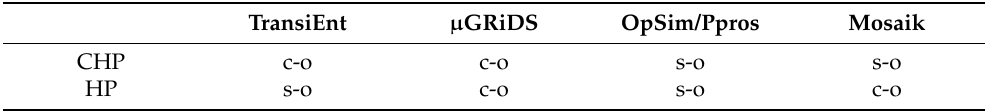
Table 3. Overview of the approaches used in the CHP and HP